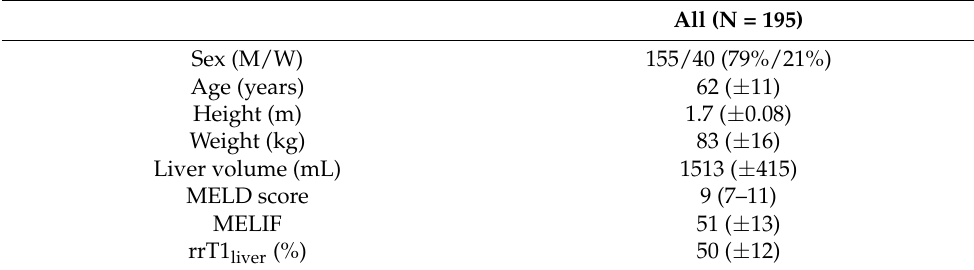
Data are presented as N (%) for categorical variables and mean ( ± standard deviation) or median (interquartile range) for continuous variables. MELD = model for end-stage liver disease. Table 2. MELIF score, rrT1 liver , and demographic characteristics by MELD group.